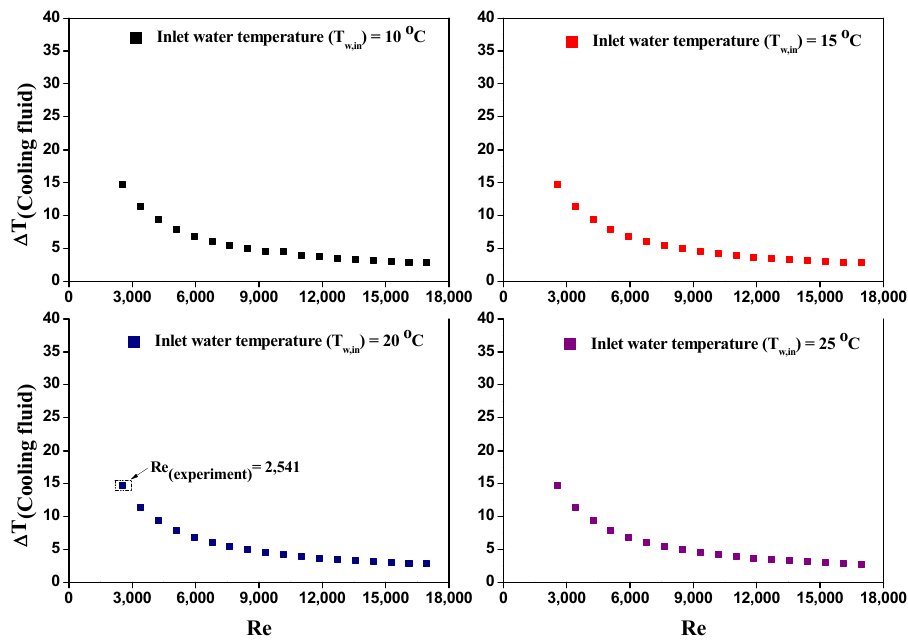
Figure 11. Variation in cold water temperature